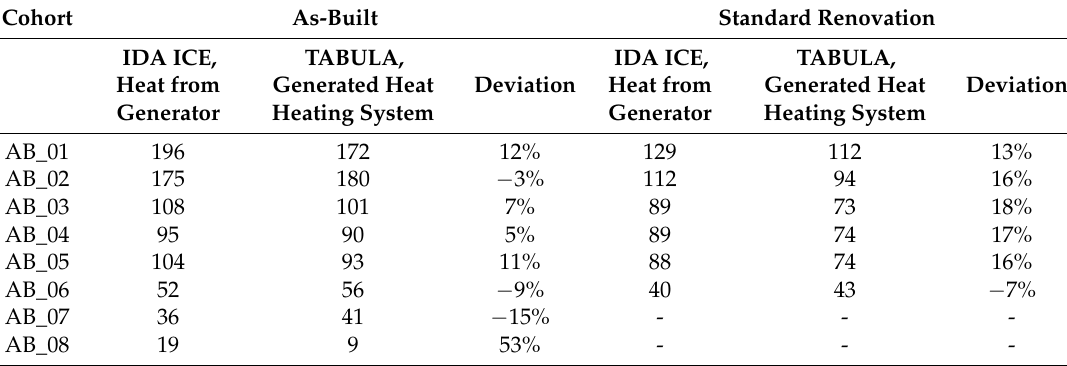
Table 5. Heating needs for radiators, electric floor heating and heating battery in kWh/(m 2 · year) for IDA ICE and TABULA, and relative deviation between the calculated heating needs.